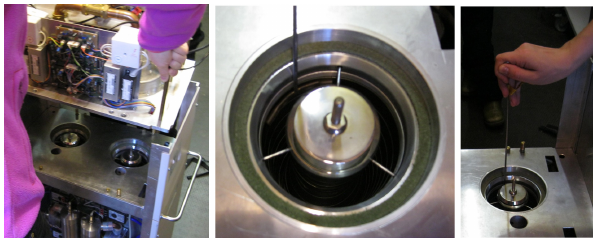
Figure 10. Cleaning electrometer rings by lifting away the sample preconditioning unit (the top part of the NAIS) and using a long cleaning rod to wipe the surface of outer electrode.